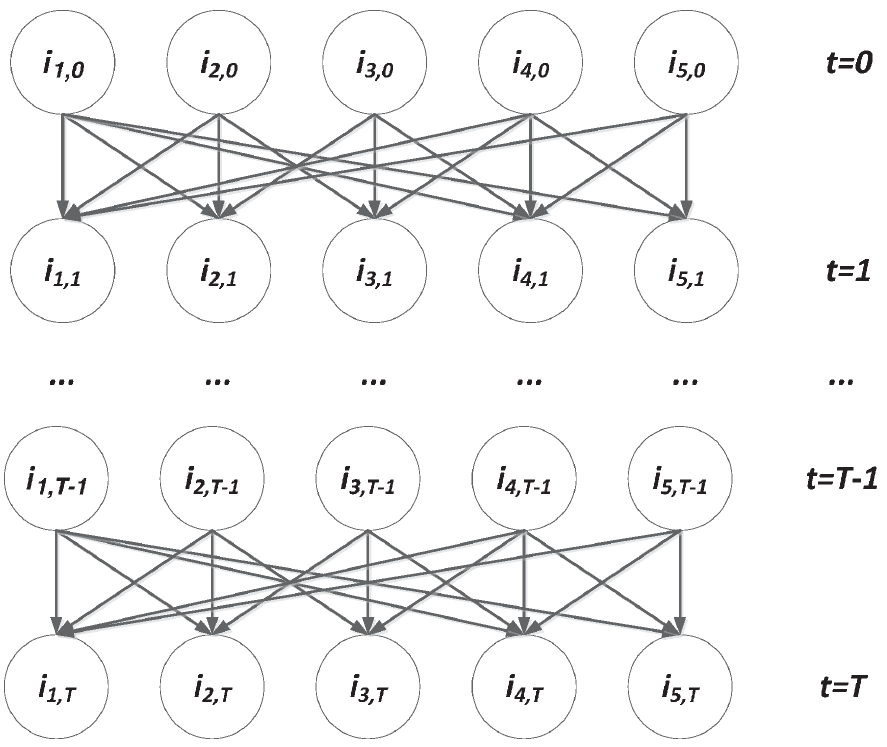
Figure 2. The Markov network, reduced from the spreading network in Figure 1 with the independence assumption. The state of each node i l , t is the number of new infections at location l (node l in Figure 1) at time t . The states of nodes at time t are independent and only dependent on the states of nodes at time { .